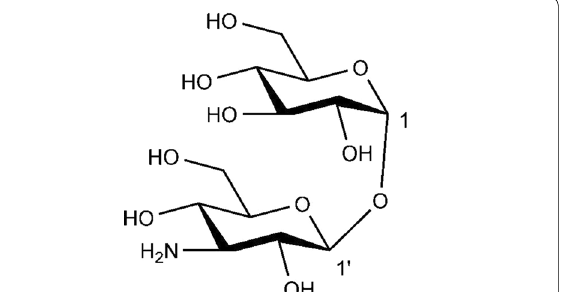
Fig. 4 Structures of 3 ′ -neotrehalosamine. The antibacterial compound was 3 ′ -neotrehalosamine(α- d -glucopyranosyl-(1